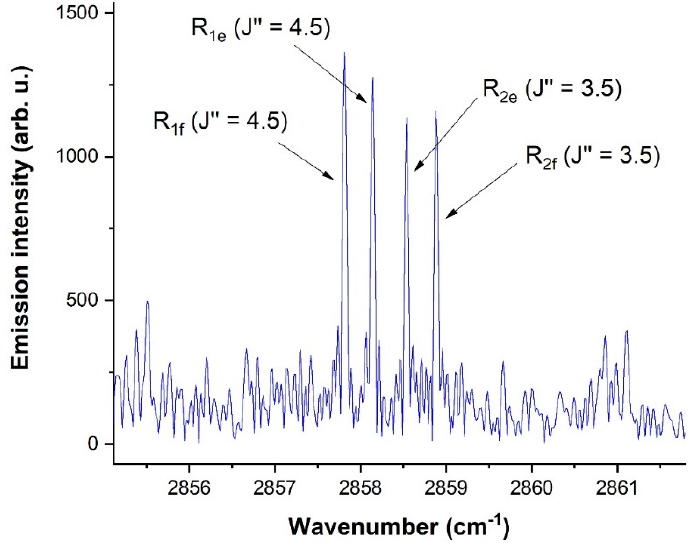
Figure 29. A detailed look at the CH quadruplet around 2858 cm − 1 .